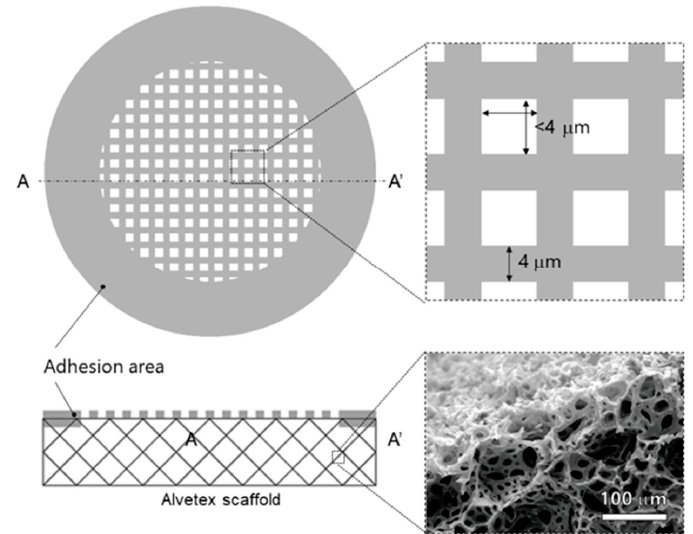
Figure 3. Schematic images of the MIS. The MIS consisted of the porous membrane with micro pore smaller than cell size, and the Alvetex sca ff old which was capable of containing cells. The size of the pore in the porous membrane was required to be smaller than 4 µ m. In the adhesion area, part of thick photoresist permeated into the Alvetex sca ff old and